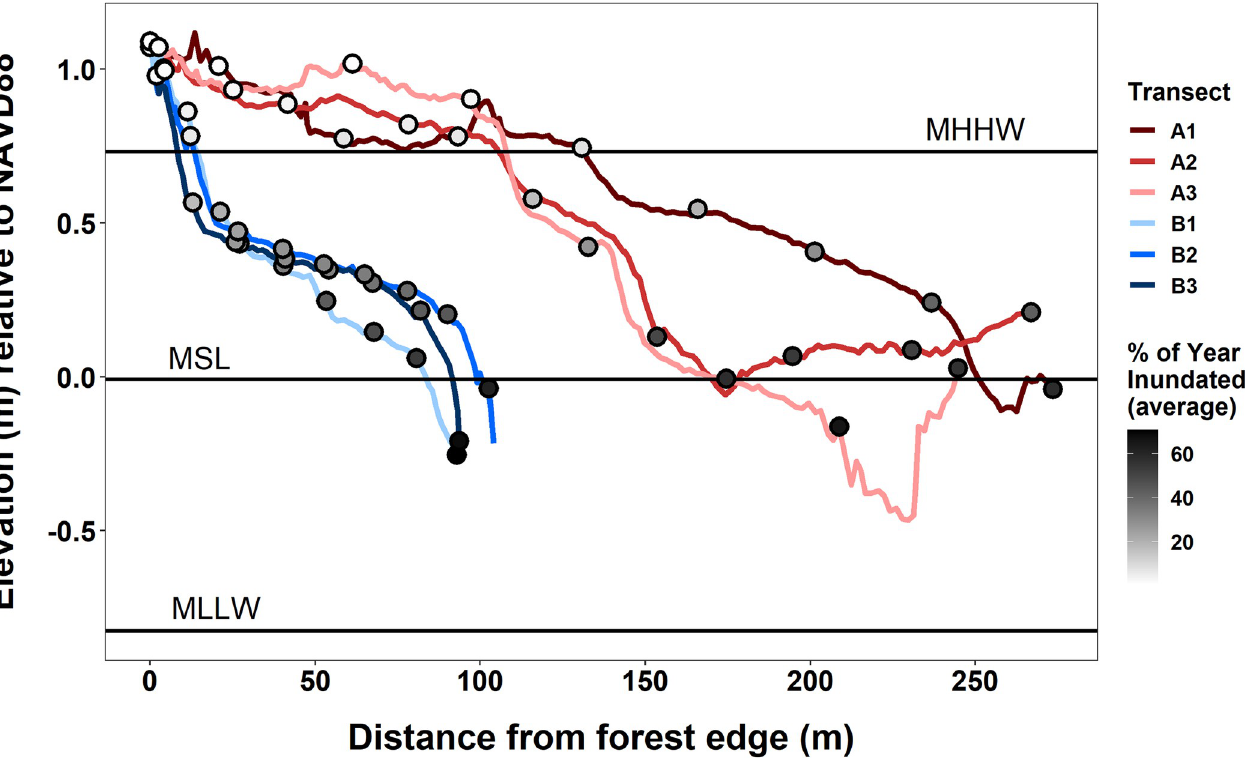
Fig 2. Transect elevation profiles. Elevation profiles estimated using RTK-GPS of the three transects taken across both Segment A (red lines) and Segment B (blue-green lines) of the Crab Haul Creek marsh platform. Points on each profile indicate the location of permanent vegetation monitoring plots designated along each transect and are shaded according to the average of the percentages of each year the plots were inundated for the entire 2009–2019